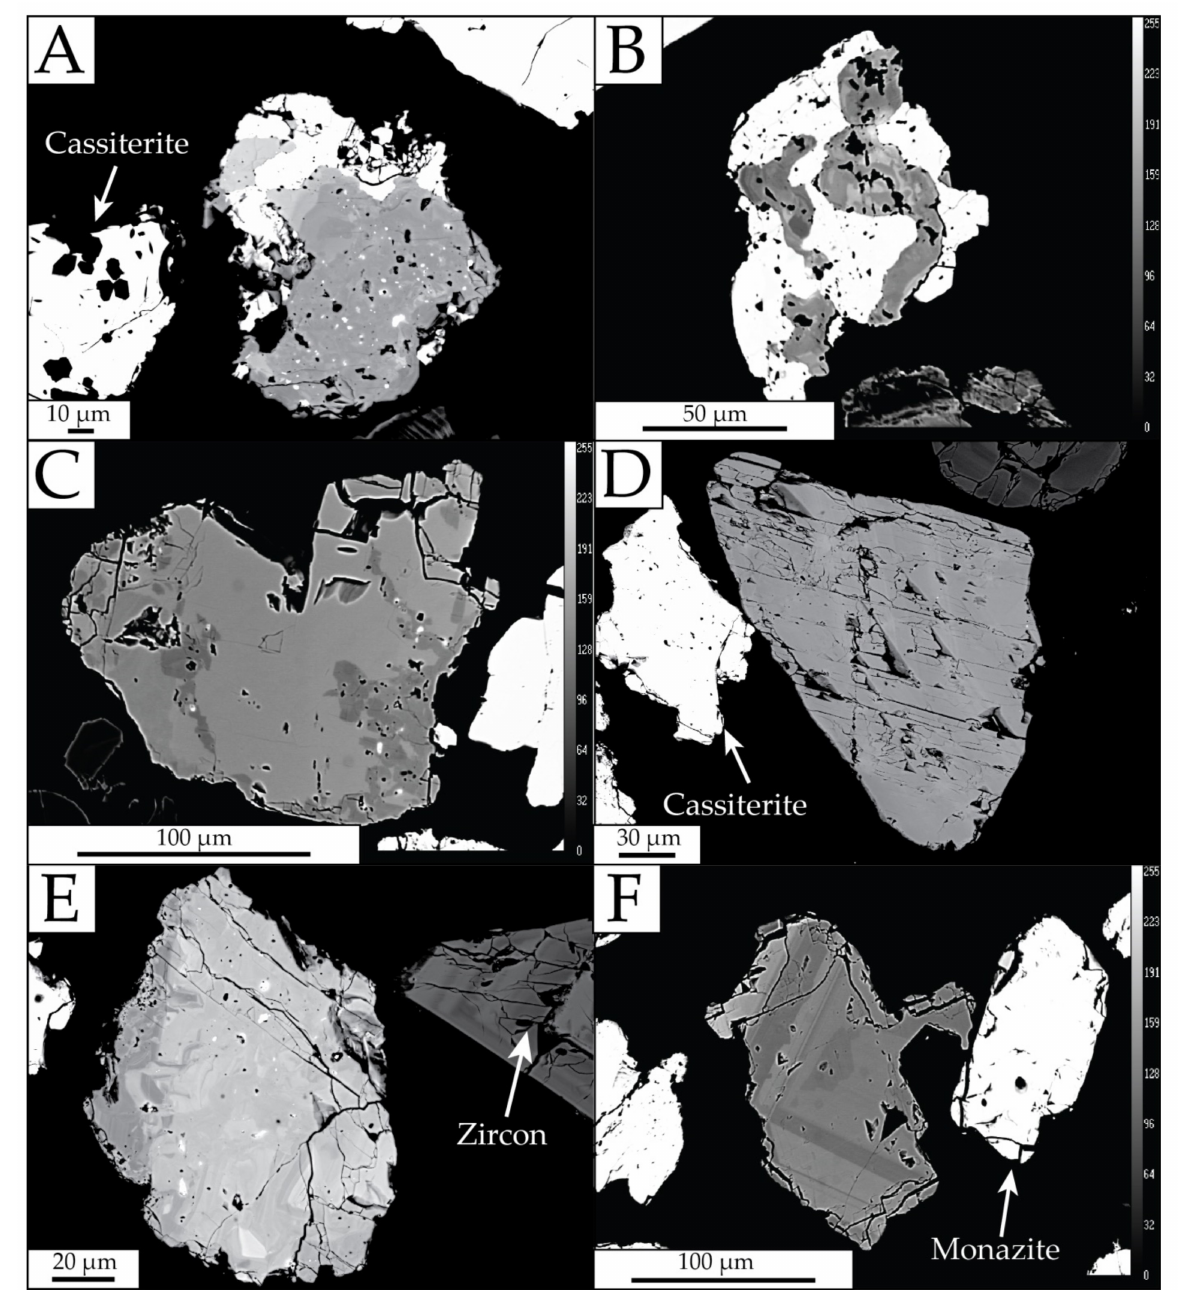
Figure 5. Backscattered electron images of xenotime grains. ( A ) Anhedral xenotime with monazite and a few thorite inclusions visible; ( B ) xenotime with cassiterite; ( C ) twin xenotime, containing several inclusions of thorite and uranothorite; ( D ) subhedral xenotime with cleavage directions visible and some fractures, without U and Th inclusions; ( E ) anhedral xenotime with irregular composition, containing cleavage directions visible and some fractures; ( F ) xenotime with oscillatory